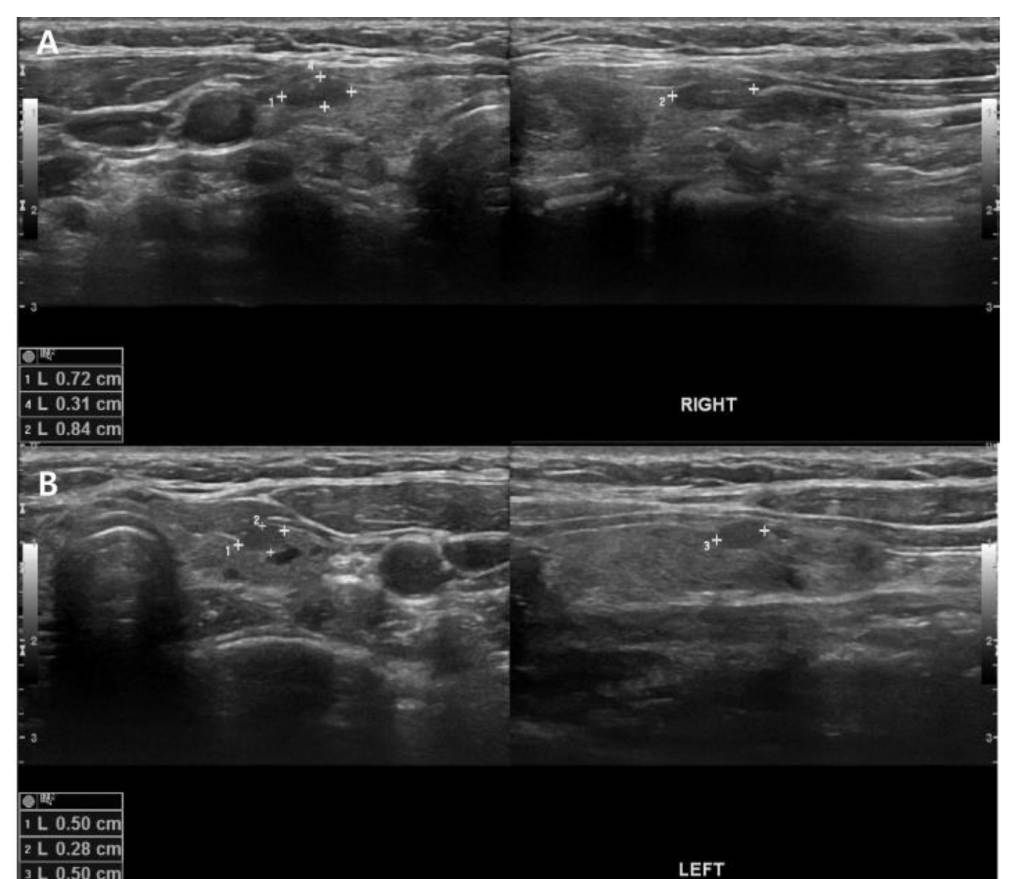
Figure 1. A 16-year-old female patient with elevated parathyroid hormone and serum calcium levels (89.6 pg/mL and 12.8 mg/dL, respectively) underwent initial neck ultrasonography (US) (( A ) right; ( B ) left) for parathyroid gland evaluation. The images showed heterogeneous echotexture thyroid parenchyme and multiple hypoechoic nodules in both glands but no demonstrable evidence of parathyroid adenoma.